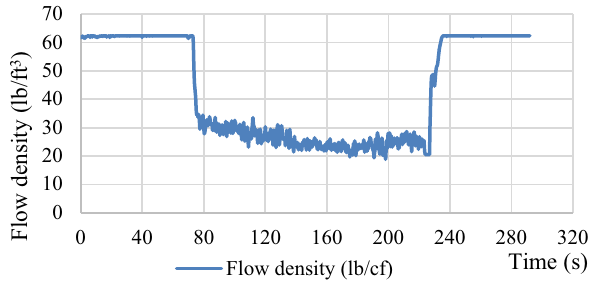
Fig. 16 An image of a rotating flat disc with three grooves for meas- uring relative displacement between the motor head and the drill pipe